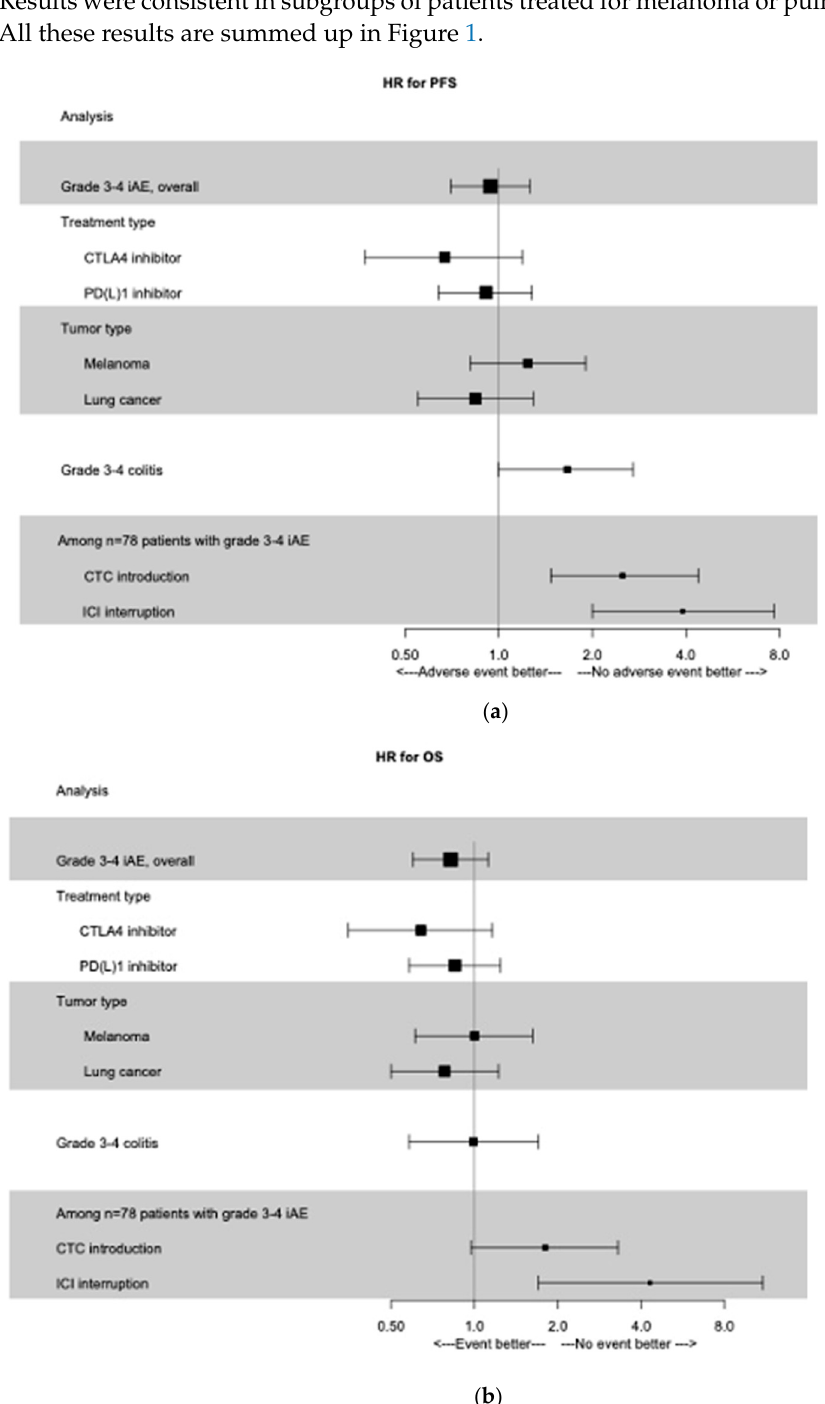
Figure 1. Time-dependent Forest Plot analysis. ( a ) Forest Plot of PFS according to grade 3 − 4 irAEs, treatment type, primary tumor type, and management of irAEs. ( b ) Forest Plot of OS according to grade 3 − 4 irAEs, treatment type, primary tumor type, and management of irAEs. irAEs, immune- related adverse events; PFS, progression free survival; OS, overall survival; CTC: glucocorticoids; ICI: immune check-point inhibitors.